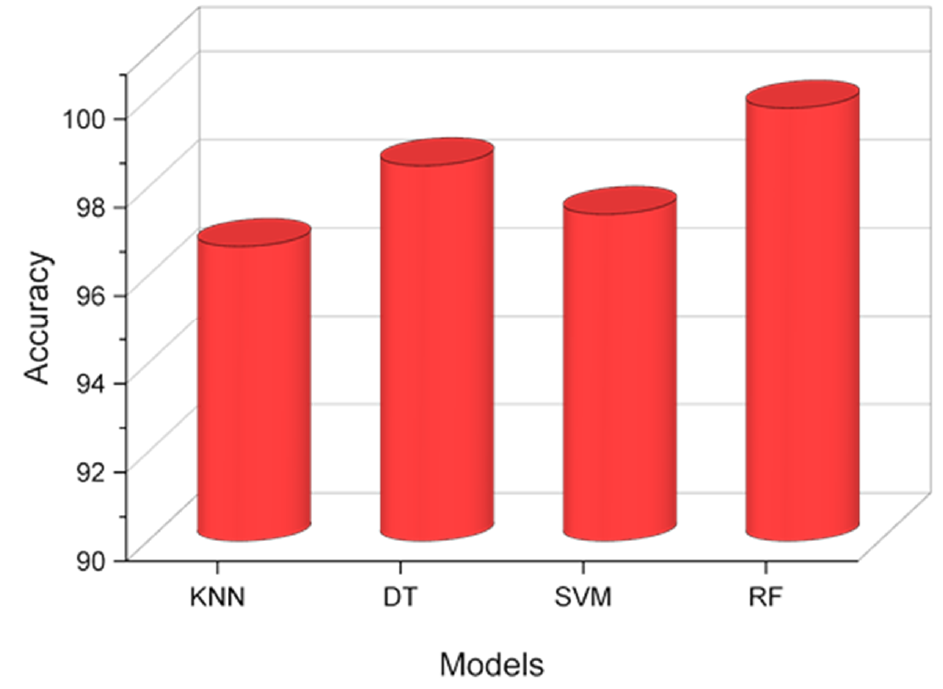
Figure 12. Accuracy of the models over test data.